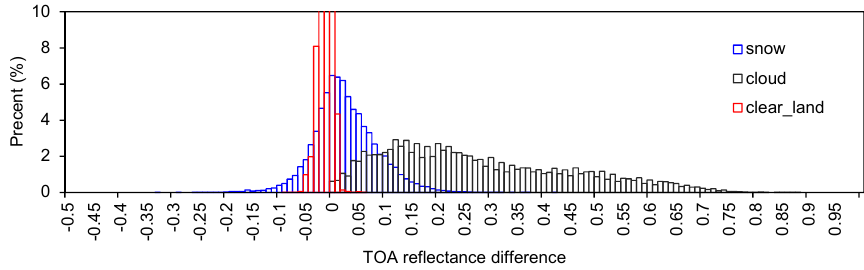
Figure 5. Histogram for Top Of Atmosphere (TOA) reflectance difference for the snow, clouds and clear ground pixels at two-day intervals.